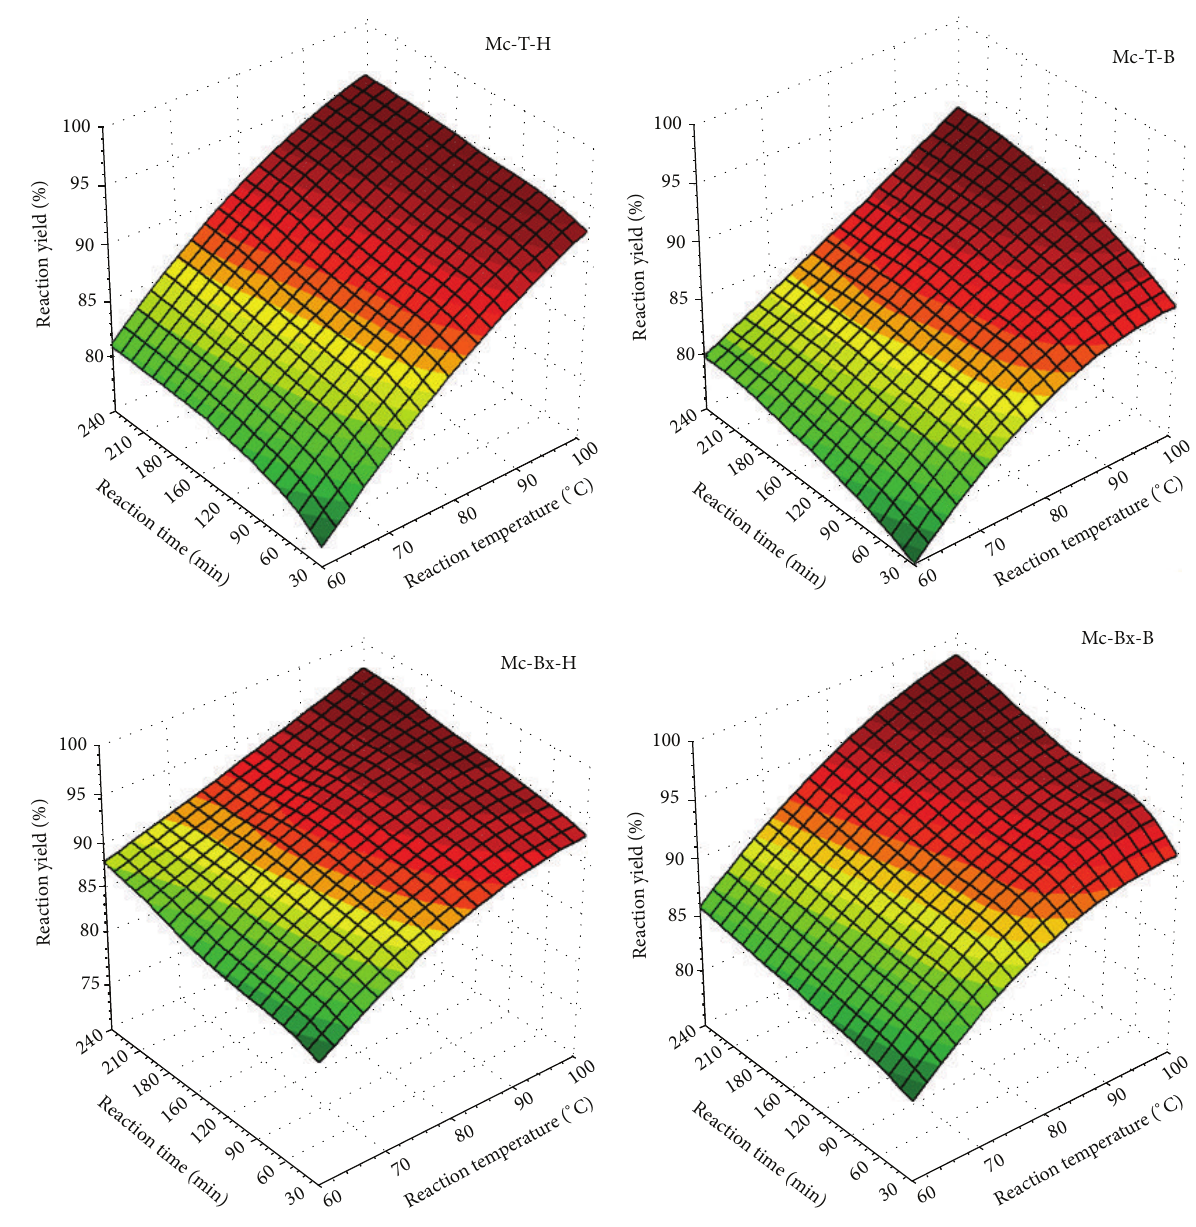
Figure 8: Reaction yields of synthesized admontite